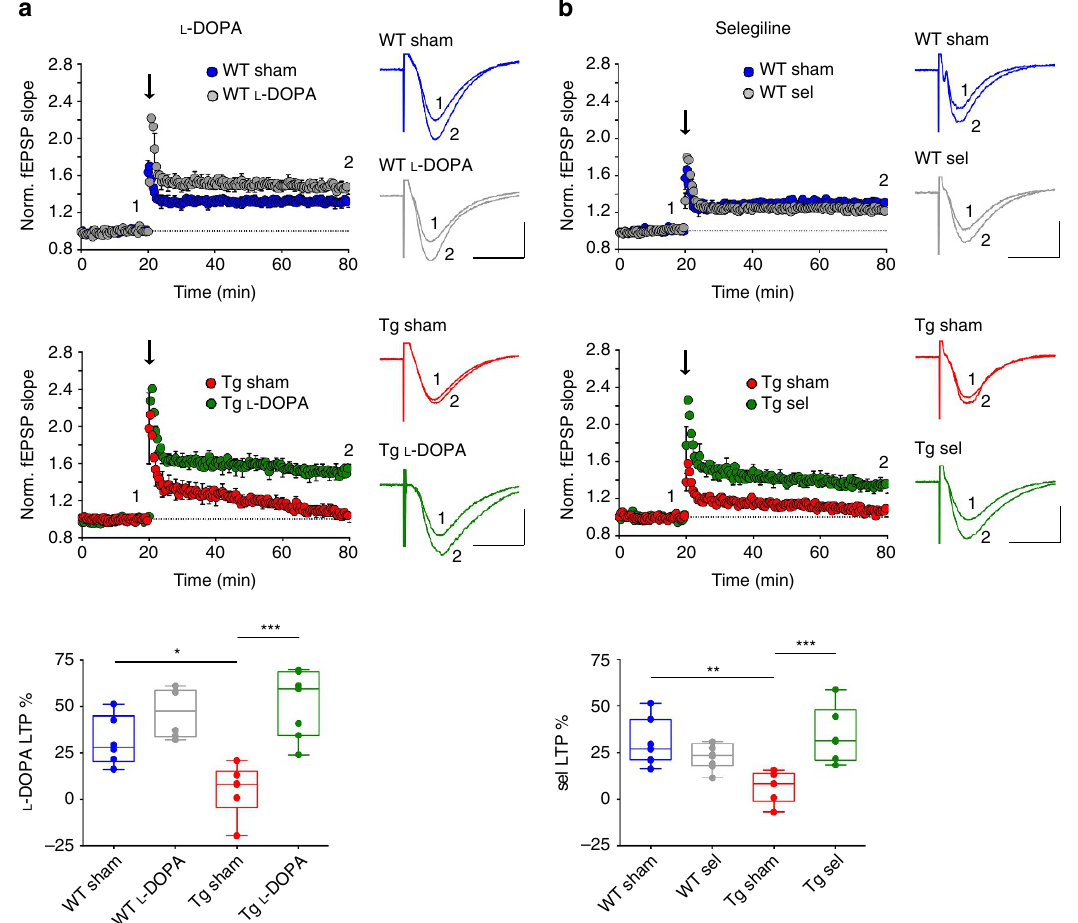
Figure 5 | Sub-chronic L -DOPA or selegiline treatment rescues CA3-to-CA1 plasticity deficits in 6-month-old Tg2576 mice. ( a , b ) Running plots show normalized fEPSP mean slope ( ± s.e.m. displayed every 2min) recorded from the dendritic region of CA1 neurons in hippocampal slices from 6-month-old saline-treated (sham) and L -DOPA- ( a ) or selegiline (sel)-treated ( b ) WTand Tg2576 mice. The arrows indicate when a high frequency train was delivered by stimulating the Schaffer collateral pathway in the CA3 region. Traces are superimposed fEPSPs recorded during baseline (1) and 1h after the train (2). The box-and-whisker plots below indicate the degree of potentiation, measured as fEPSP slope increase from baseline, 55–60min after the train ( a , WT: n ¼ 6 slices from 3 sham, 6 slices from 4 L -DOPA-treated mice; Tg: n ¼ 6 slices from 3 sham, 7 slices from 3 L -DOPA-treated mice;